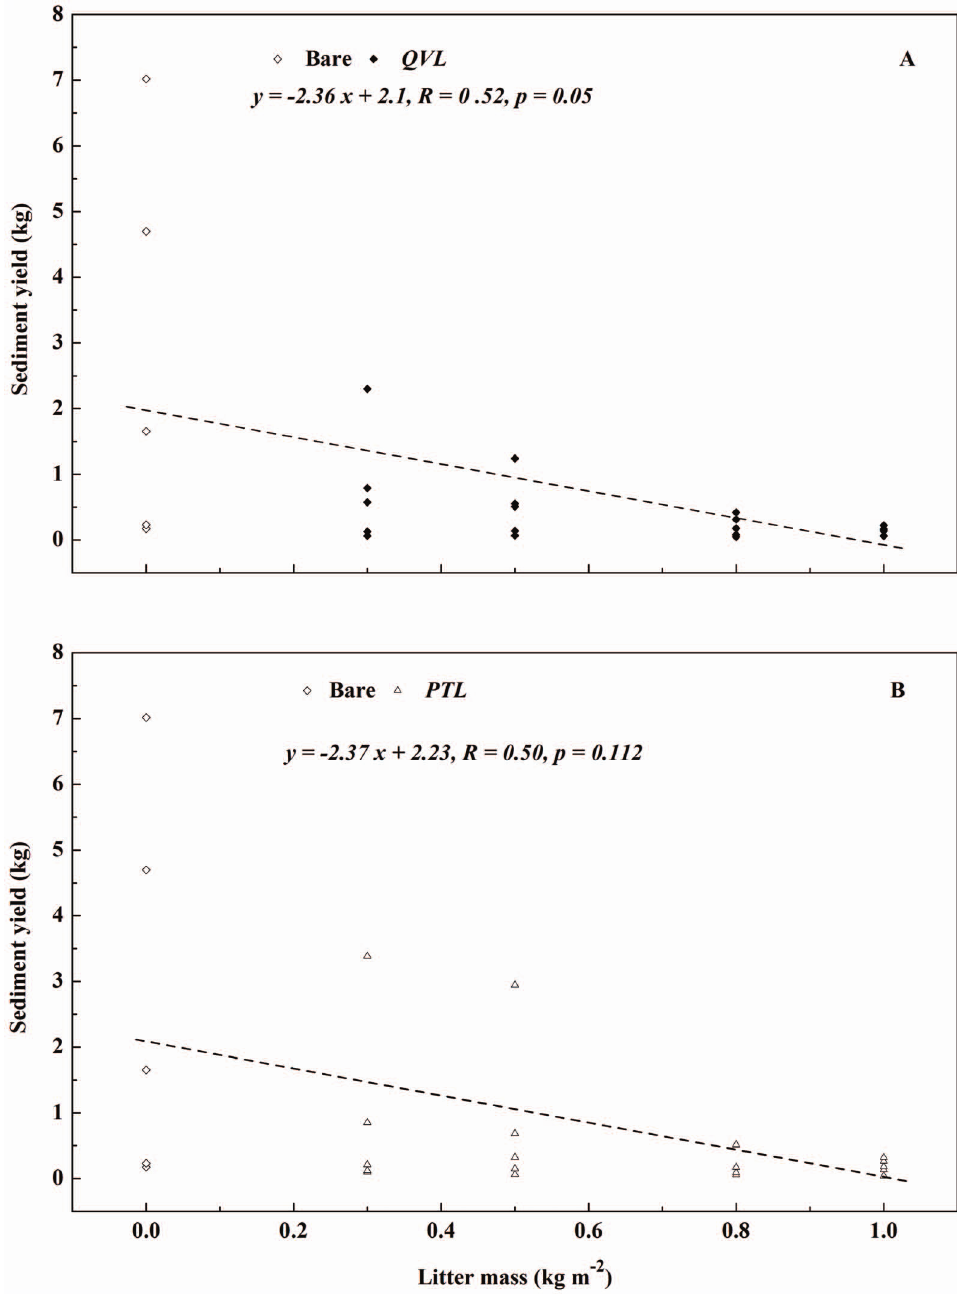
Figure 7. Relationship between litter mass and sediment yield for bare-soil plots (open diamonds), Quercusvariabilis litter (closed diamonds), and Pinustabulaeformis litter (open triangles) for five rainfall intensities.